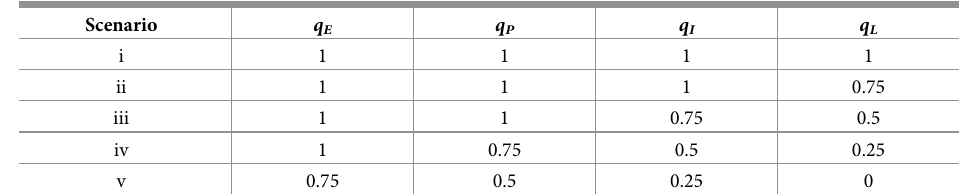
Table 1. Susceptibility to successive infections. Scenario